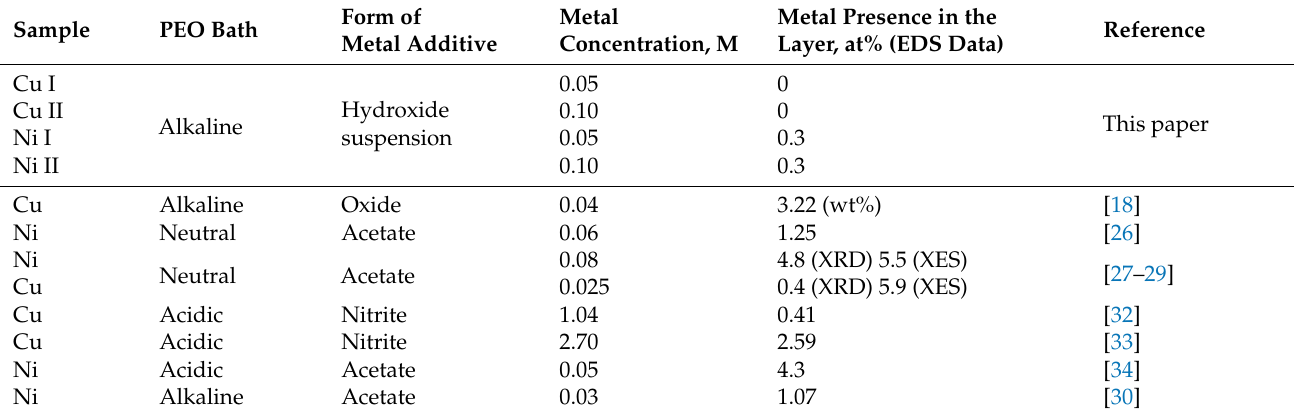
Table 3. Comparison of the amount of Ni and Cu incorporated during PEO in various electrolytes.